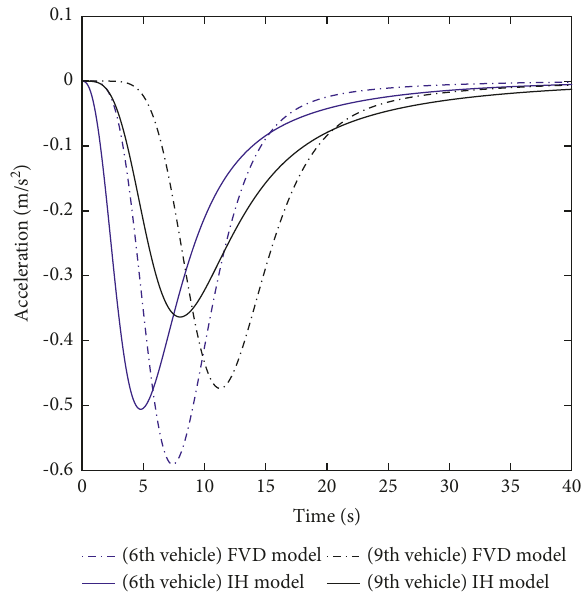
Figure 6: Comparison of two vehicles’ acceleration during the arrival process simulated by the FVD and IH